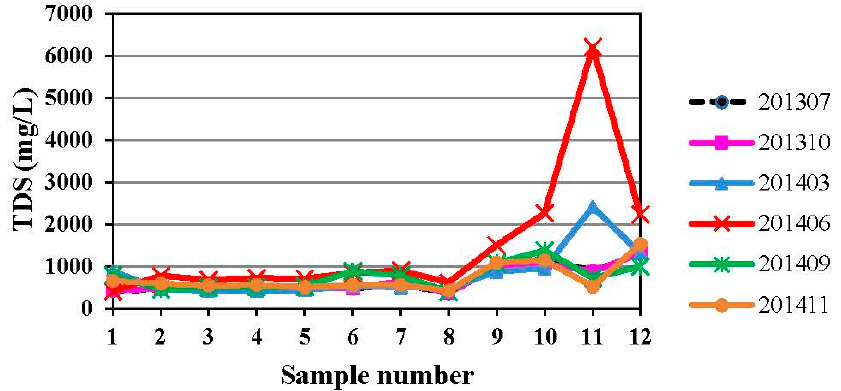
Figure 3. Spatial and temporal variations in TDS concentration in collected water samples. See Figure 1 for sample